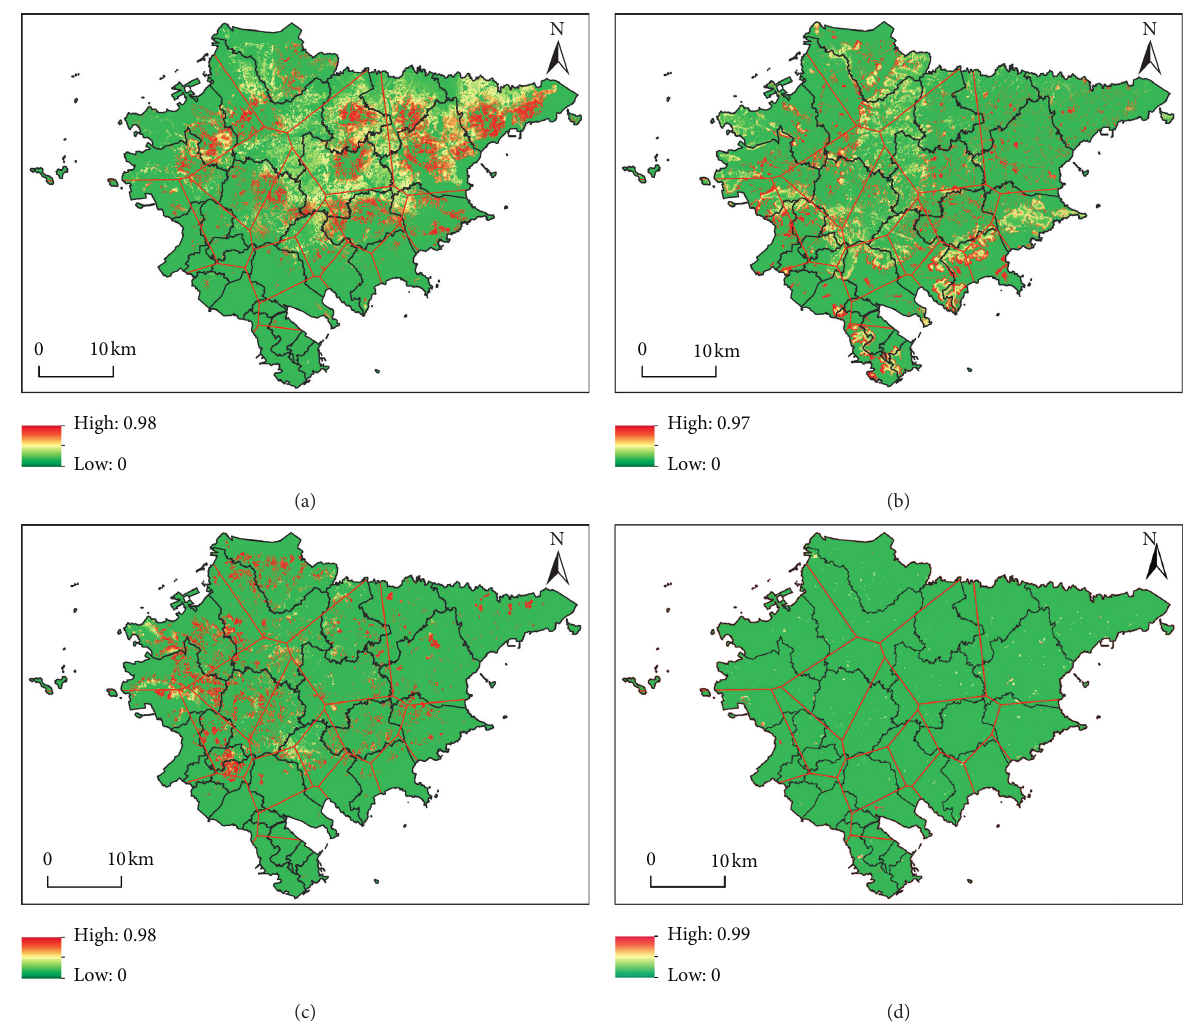
Figure 6: Spatial distribution of land use transfer potential. (a) Arable land to construction land. (b) Forestland to construction land. (c) Garden to construction land. (d) Other land to construction